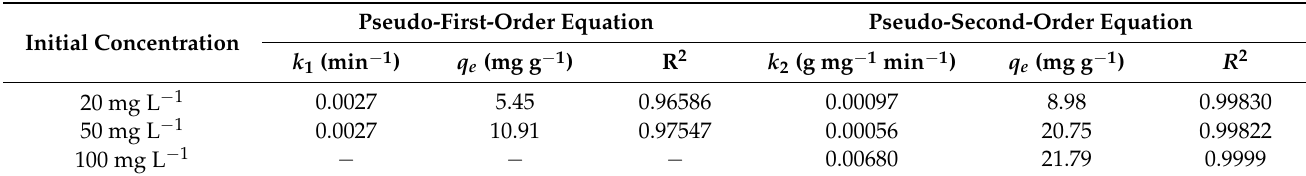
Table 4. Kinetic parameters of As(III) adsorption by the D-Mn gel.